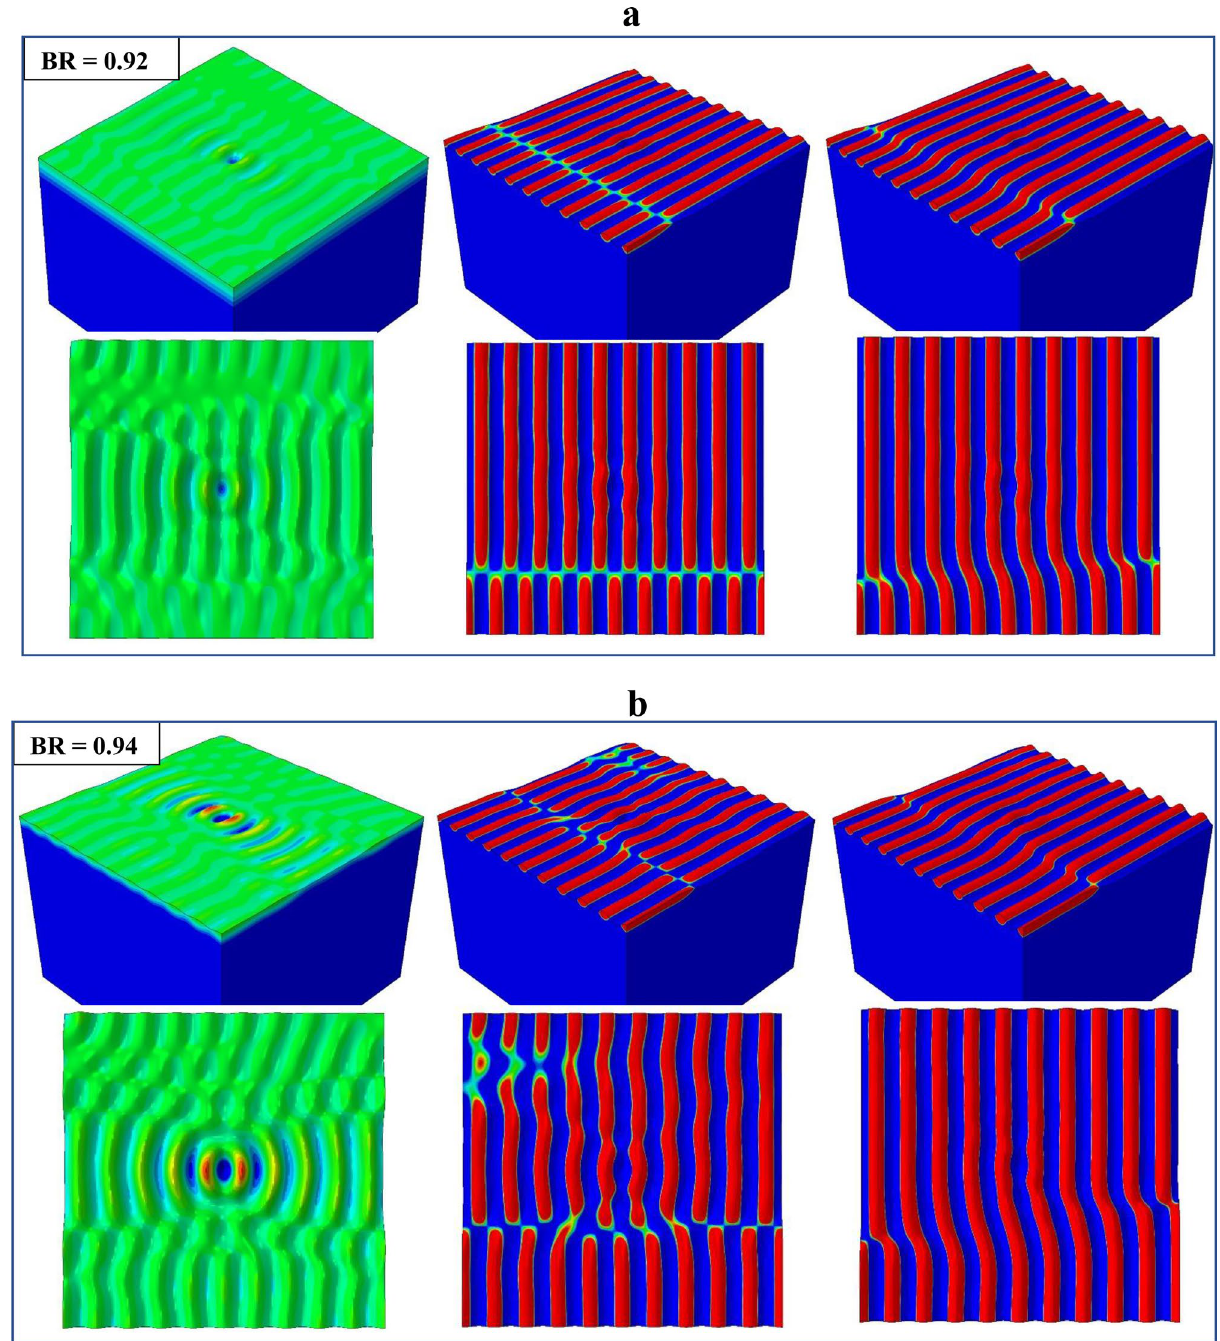
Figure 8. Formation and progression of “branched” wrinkles through the link-up process under the influence of loading biaxiality. ( a ) BR = 0.92 and ( b ) BR =